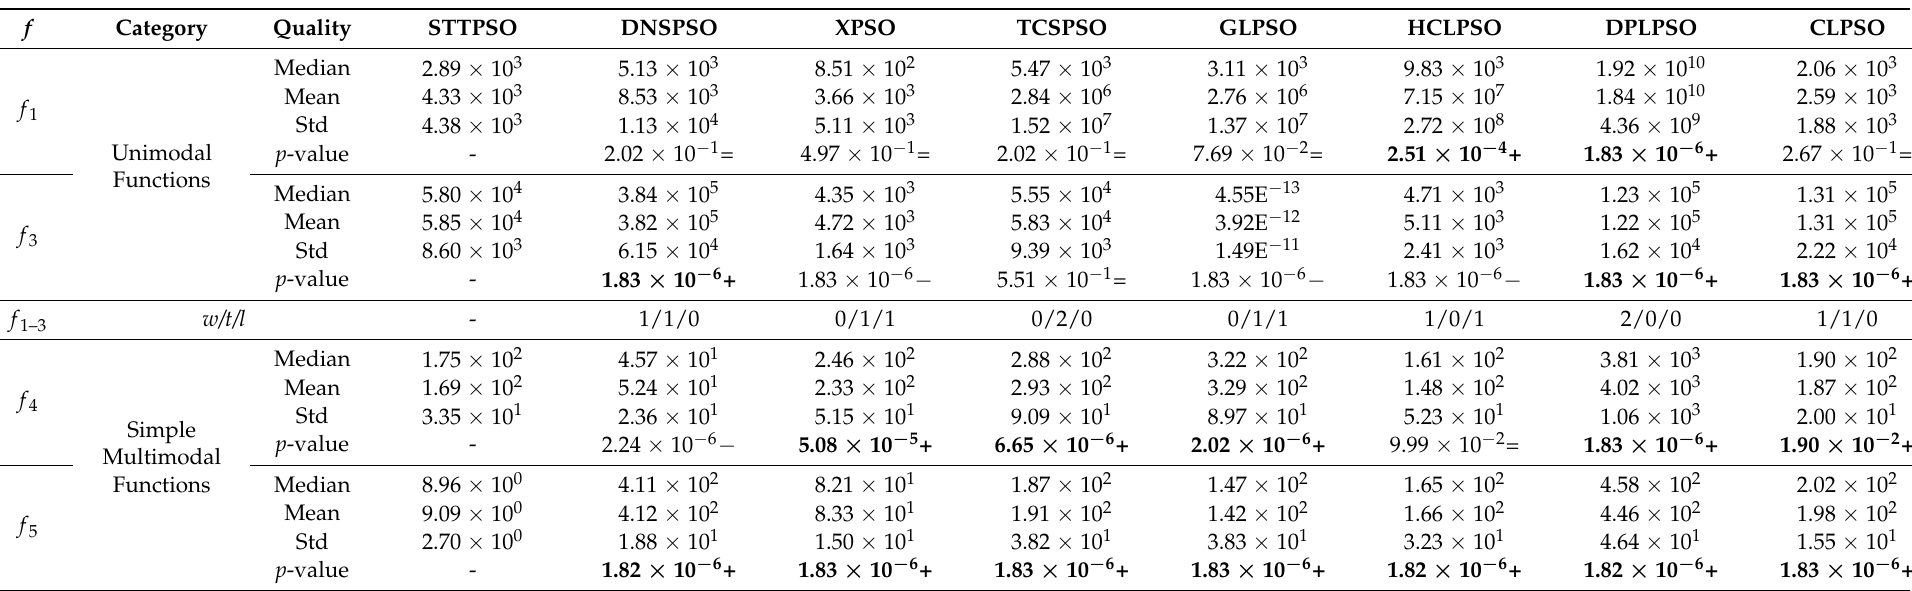
Table 4. Comparison results between the proposed STTPSO and the 7 state-of-the-art and popular PSO variants on the 50- D CEC 2017 benchmark functions. The highlighted p -values means that the proposed STTPSO is significantly better than the associated compared algorithms on the corresponding